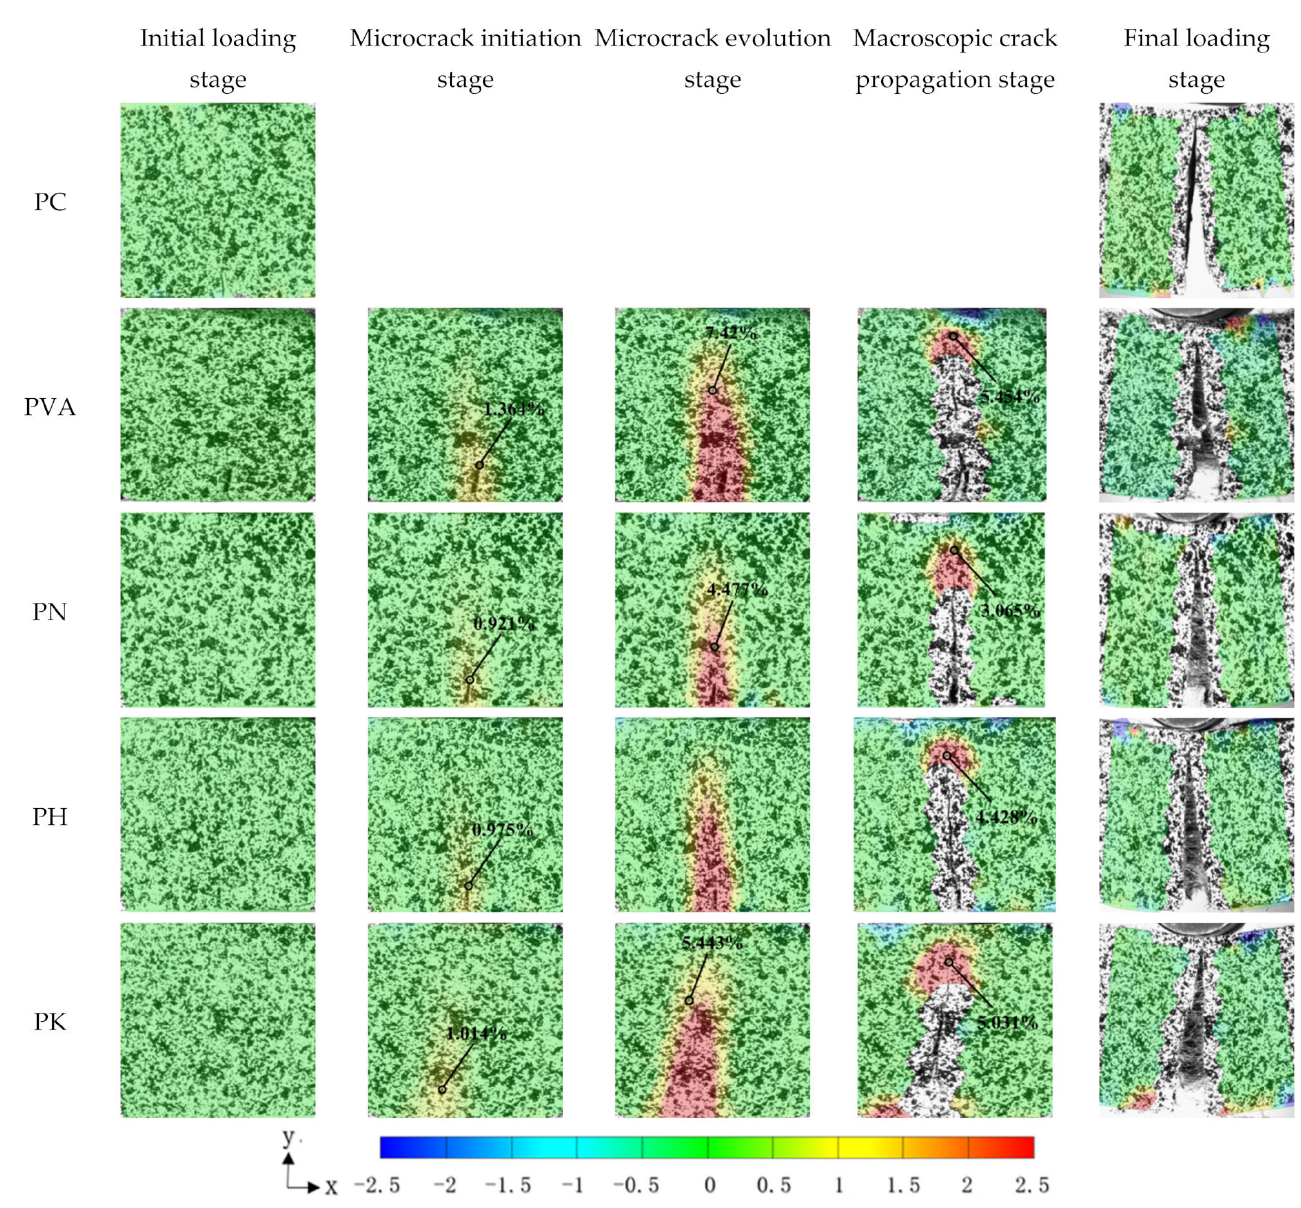
Figure 7. Strain field along X direction of the specimens with 1% fiber